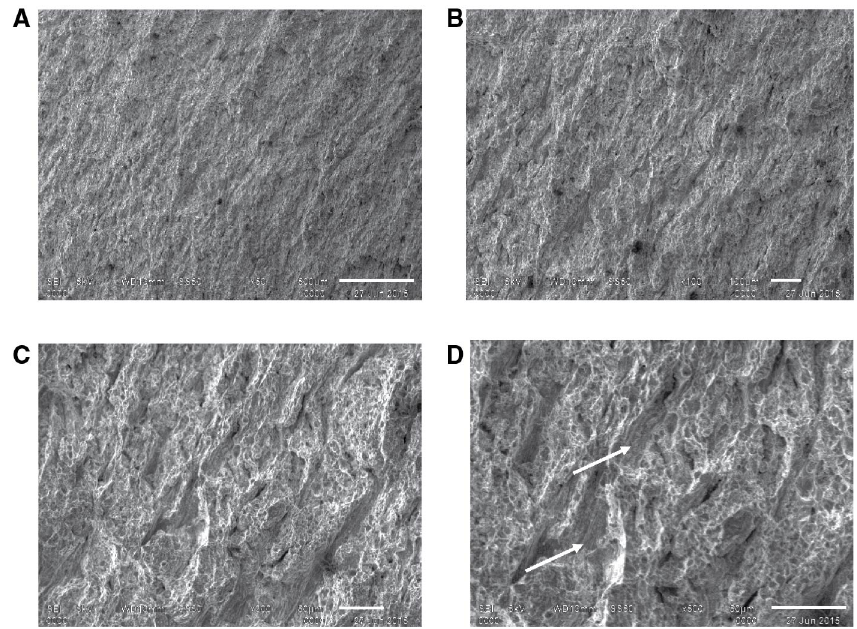
Figure 15: (A) Scanning electron micrograph of the weld zone (advancing side) at a magnification of 50×. (B) SEM of the weld zone (advancing side) at a magnification of 100×. (C) SEM of the weld zone (advancing side) at a magnification of 300×. (D) SEM of the weld zone (advancing side) at a magnification of